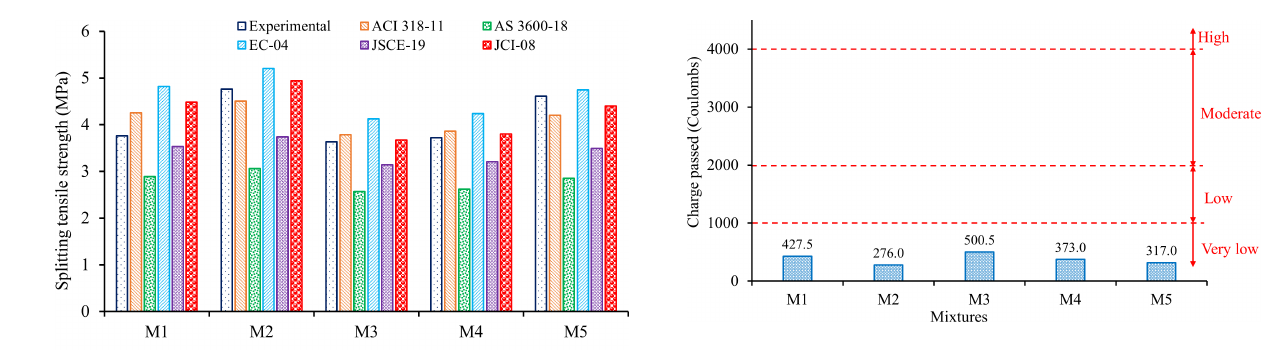
Fig. 7. Rapid chloride penetration test of all mixtures at 28